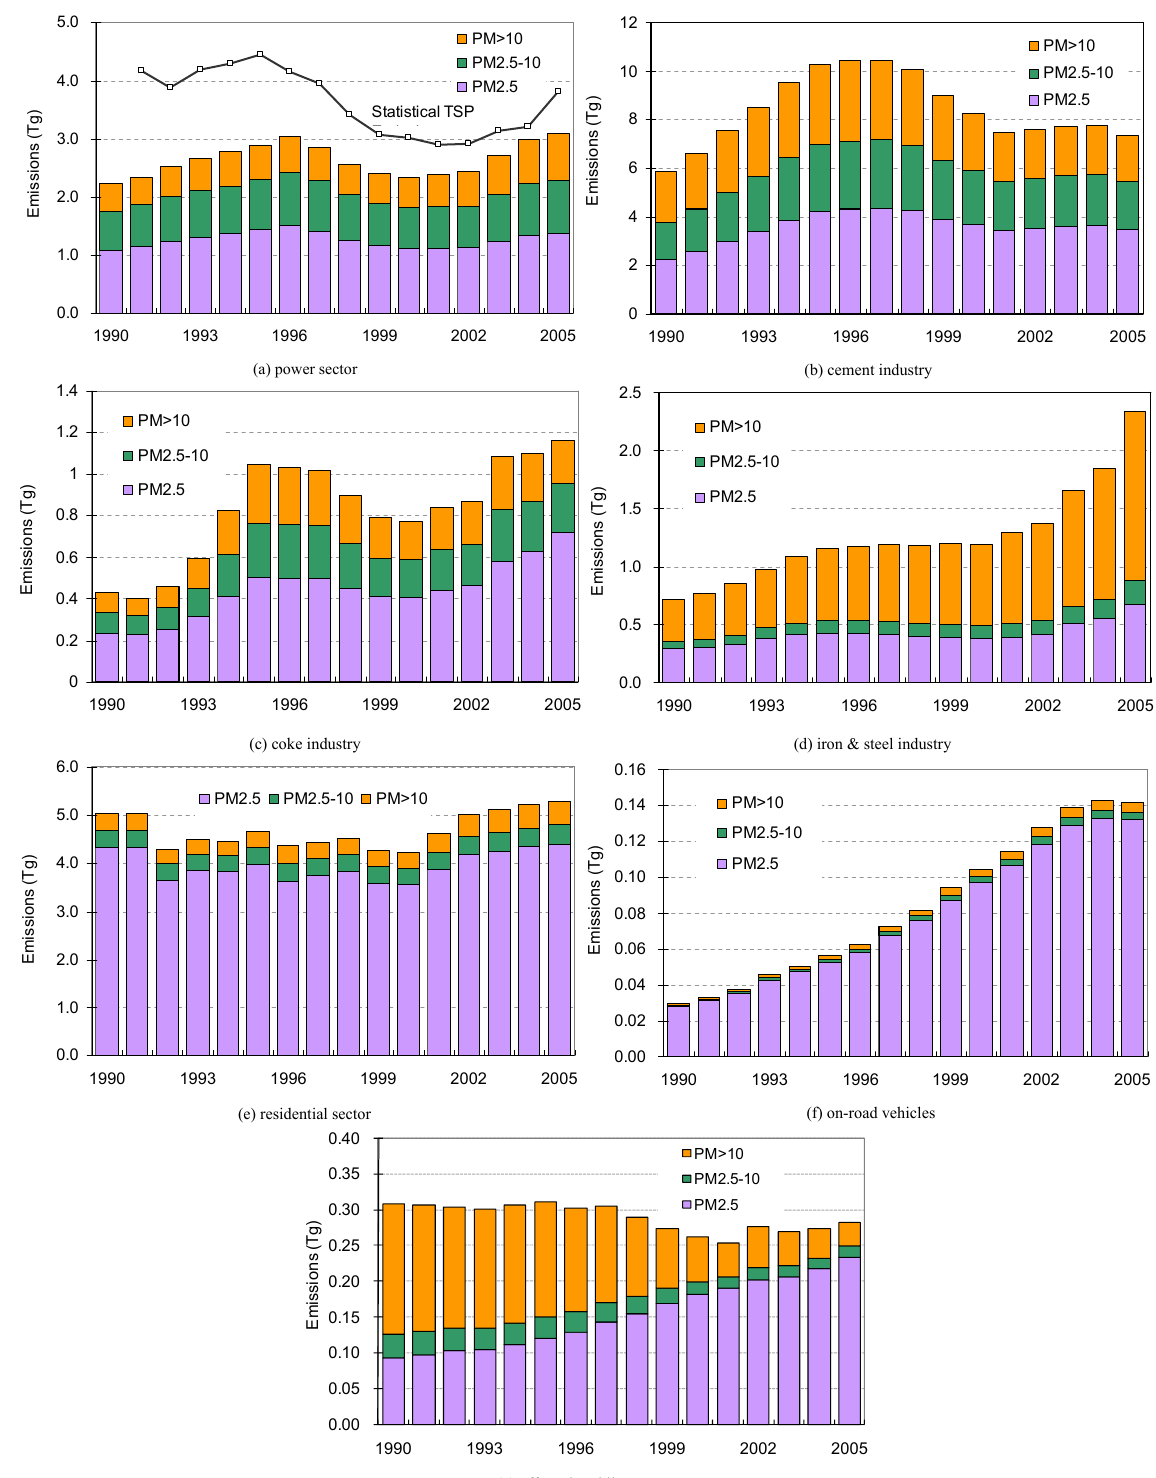
Fig. 10. PM emissions during 1990–2005 from (a) power sector, (b) cement industry, (c) coke industry, (d) iron and steel industry, (e) resi- dential sector, (f) on-road vehicles and (g) off-road mobile